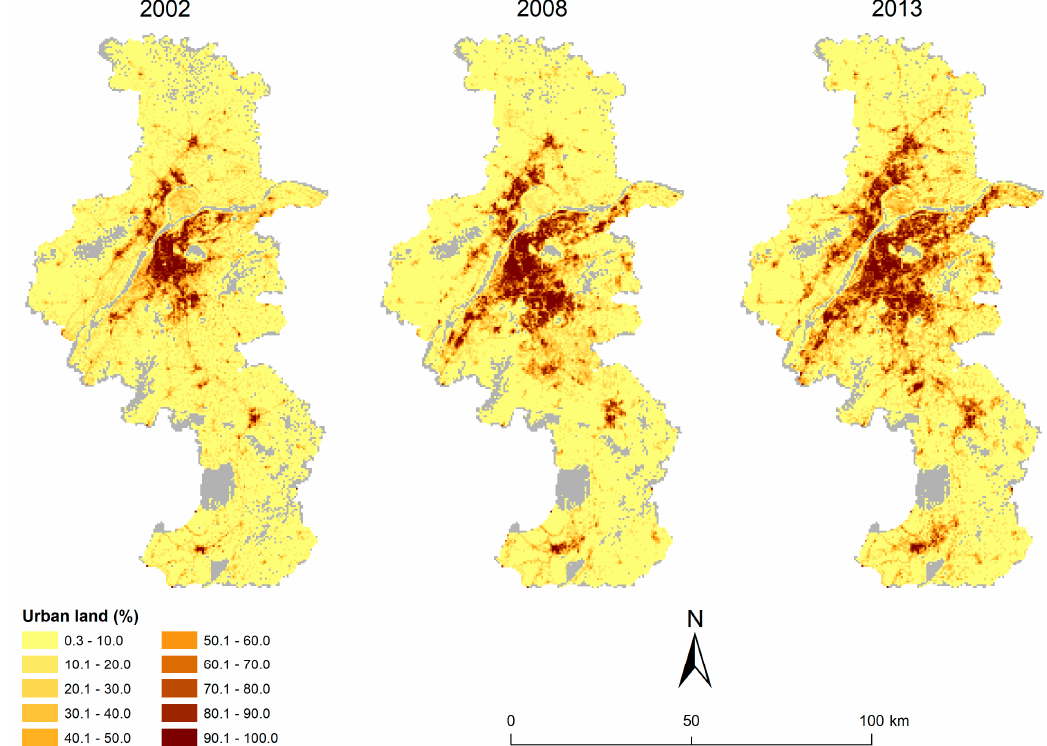
Figure 8. Spatial distribution of urban land in Nanjing.